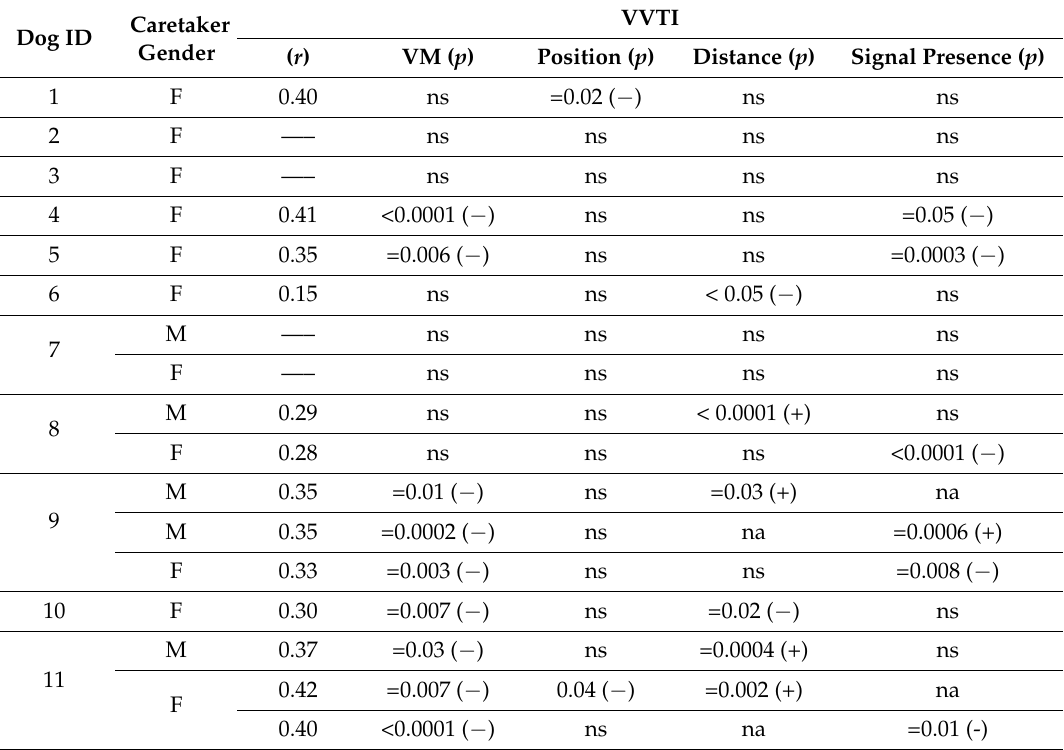
Table 6. Predictors of VVTI during sedentary